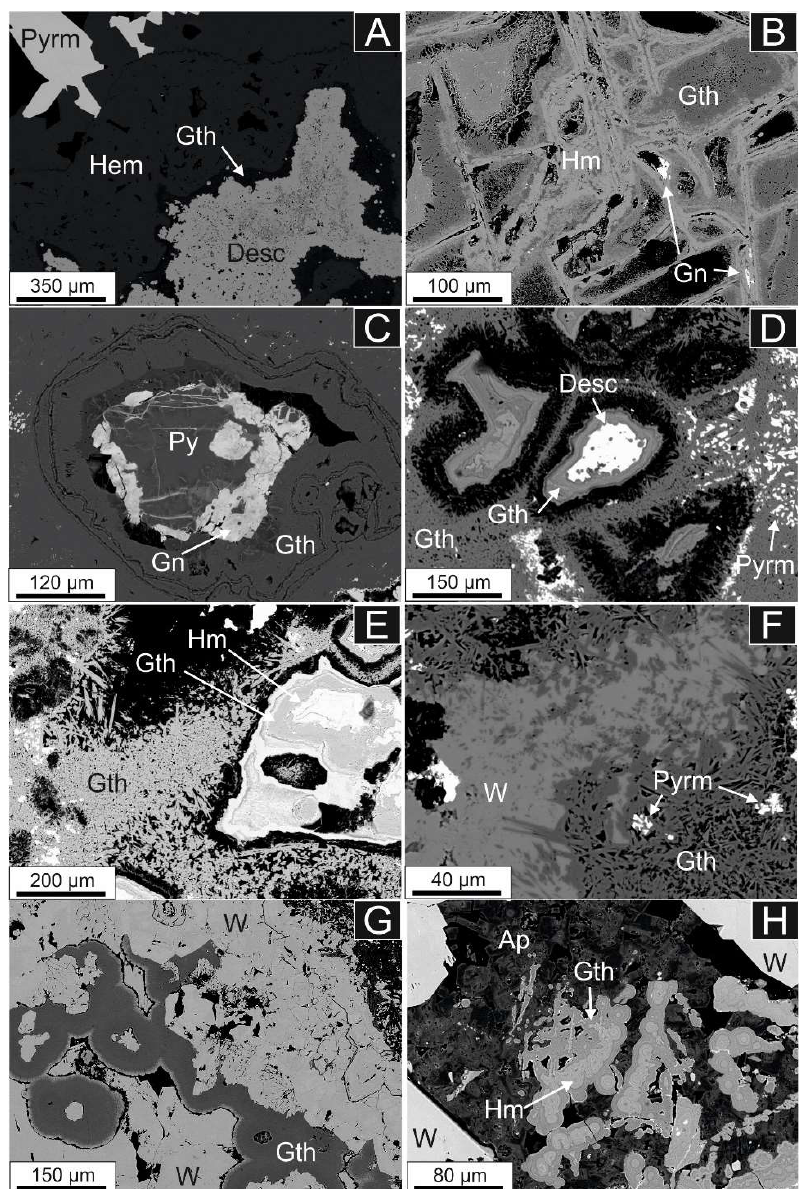
Figure 5. Petrography of Fe-oxy-hydroxides in the Kabwe clusters 1, 2, 3 and 4 (Mondillo et al. [19], unpublished